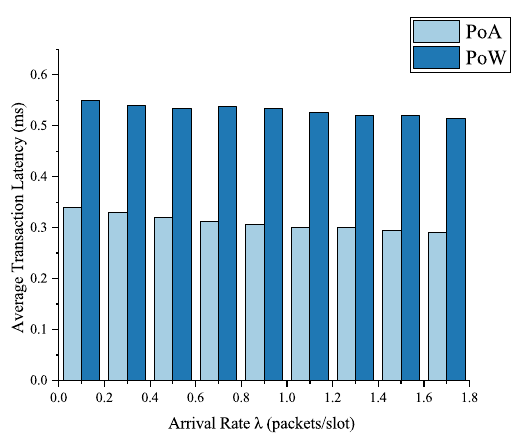
Figure 8. Average transaction latency of proof of authority (PoA) and proof of work (PoW) blockchain systems.